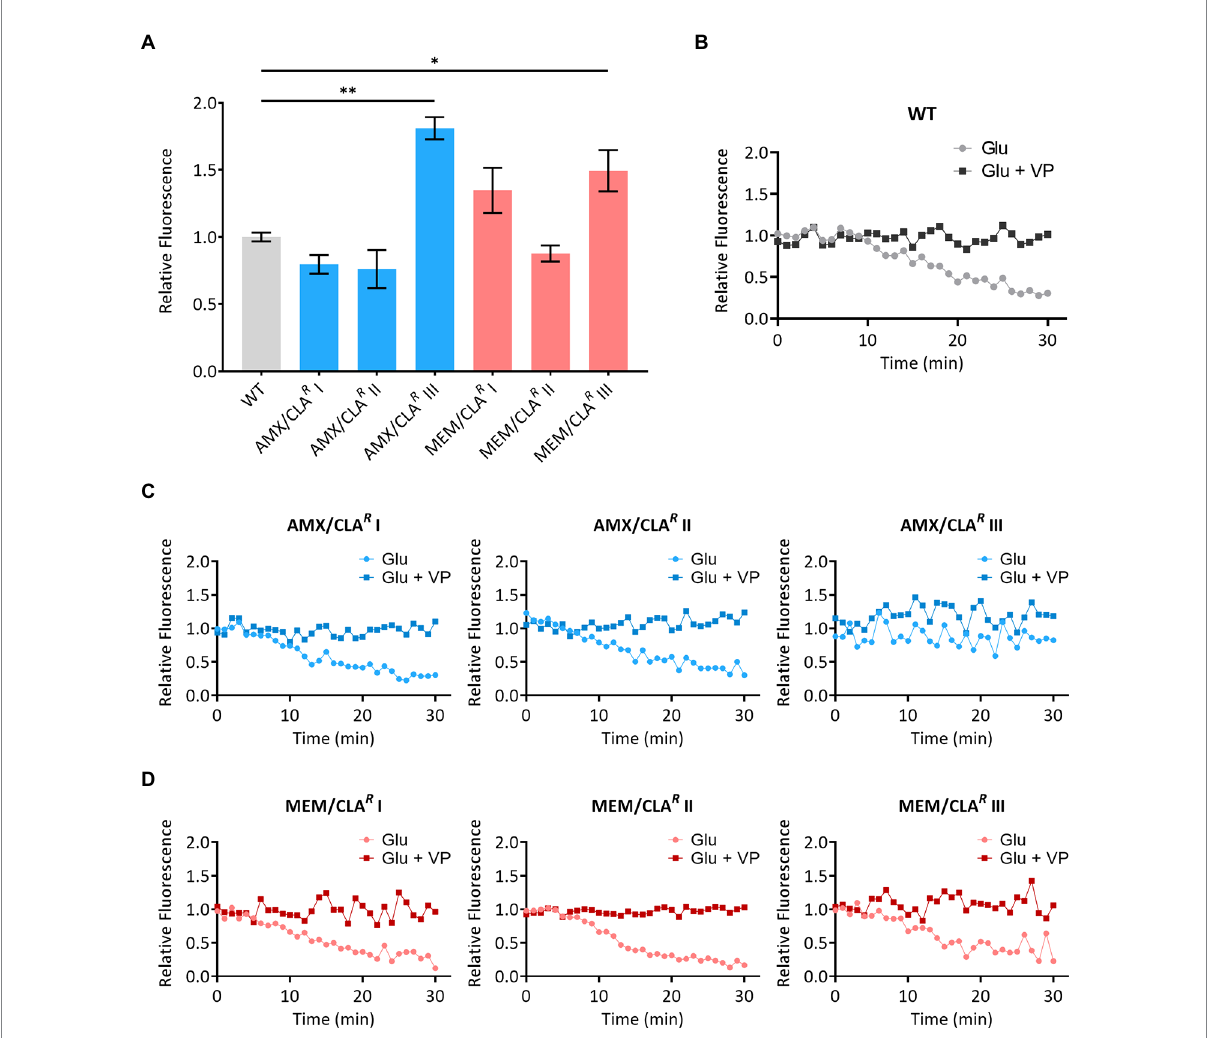
FIGURE 5 Accumulation and efflux of ethidium bromide by Msm parental strain and beta-lactam-resistant mutants. (A) Mean relative fluorescence at 60 min was calculated from assays with two biological replicates for each strain and error bars express standard deviations. The significance of the differences between samples of resistant derivatives and the wild type (WT) was determined using an ANOVA test: *when p ≤ 0.05; **when p ≤ 0.01. (B) Efflux activity of the WT and resistant mutants isolated with amoxicillin/clavulanate (C) or meropenem/clavulanate (D) , in the presence of glucose (Glu) or glucose plus verapamil (VP). AMX, amoxicillin; CLA, clavulanic acid; MEM,